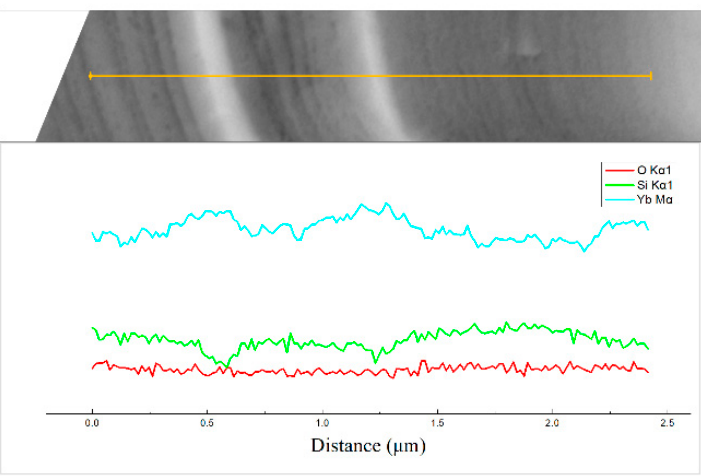
Figure 4. EDS line scan result of the as-sprayed ytterbium silicate top-coat prepared by parameter set A.